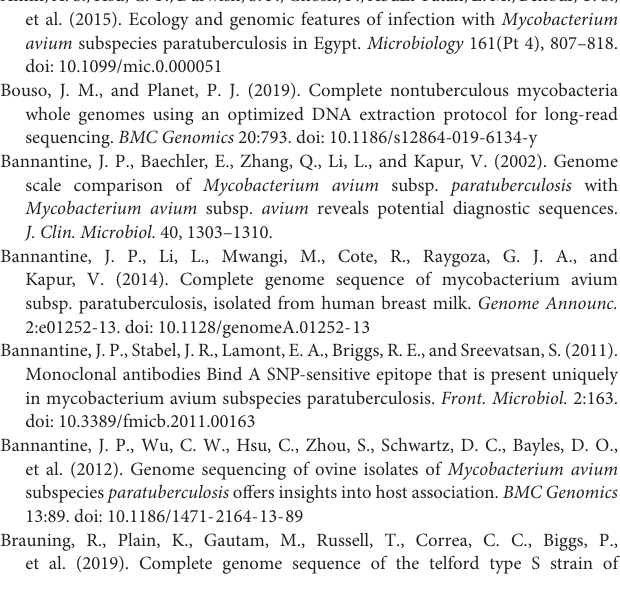
tag, protein ID and expression product. TABLE S3 | Pseudogenes in Map K-10. A total of 199 pseudogenes are listed along with their start and stop coordinates on the K-10 RefSeq annotation. The old locus tag is listed if applicable. TABLE S4 | Complete and partial copies of IS1245 among non- Map genomes. The criteria to be listed as a functional copy of IS1245 is that the product accession must be WP_011725525.1 and the size of the element must be 1,233 bp. Any other size was considered a partial copy and a pseudogene. Each IS1245 copy is listed along with strain designation and locus tag.